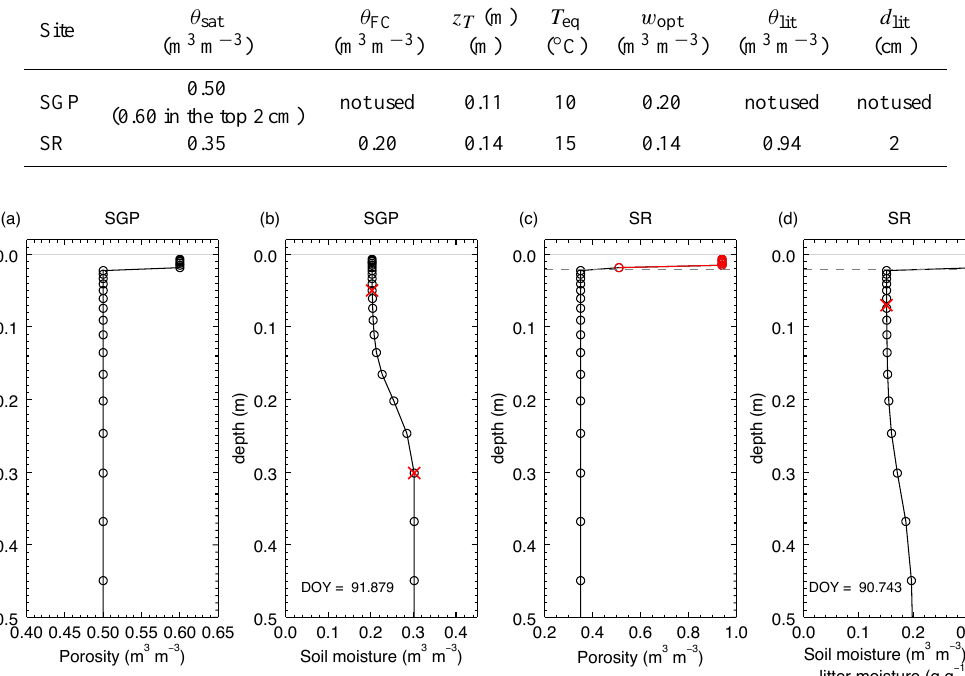
Table 2. Site-specific parameters (SR: Stunt Ranch, CA; SGP: Southern Great Plains, OK).